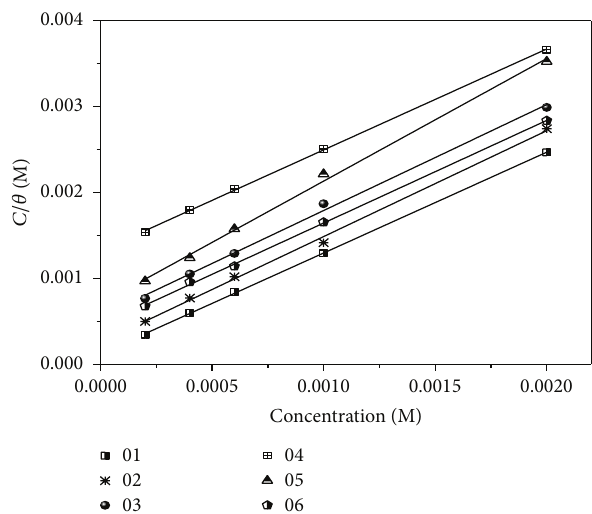
Figure 4: Langmuir isotherm plots for adsorption of inhibitors (01– 06) on the mild steel in 1N H 2 SO 4